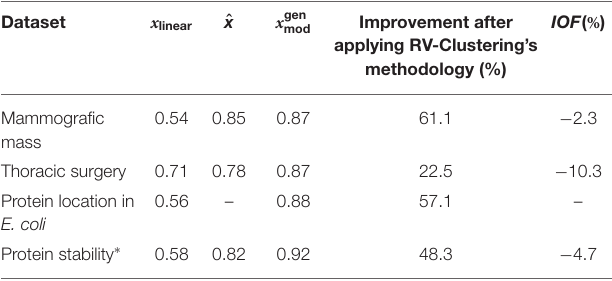
TABLE 1 | Evolution of performance (accuracy) of the models generated in different progressive steps of the proposed methodology. Dataset